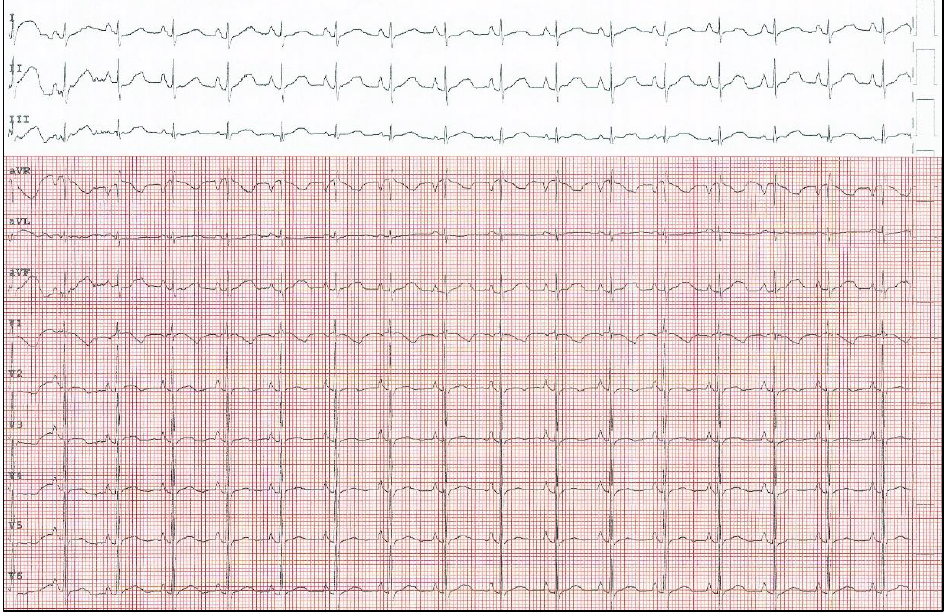
Figure 2. Restoration of sinus rhythm in patient with JET treated with ivabradine in combination with flecainide.